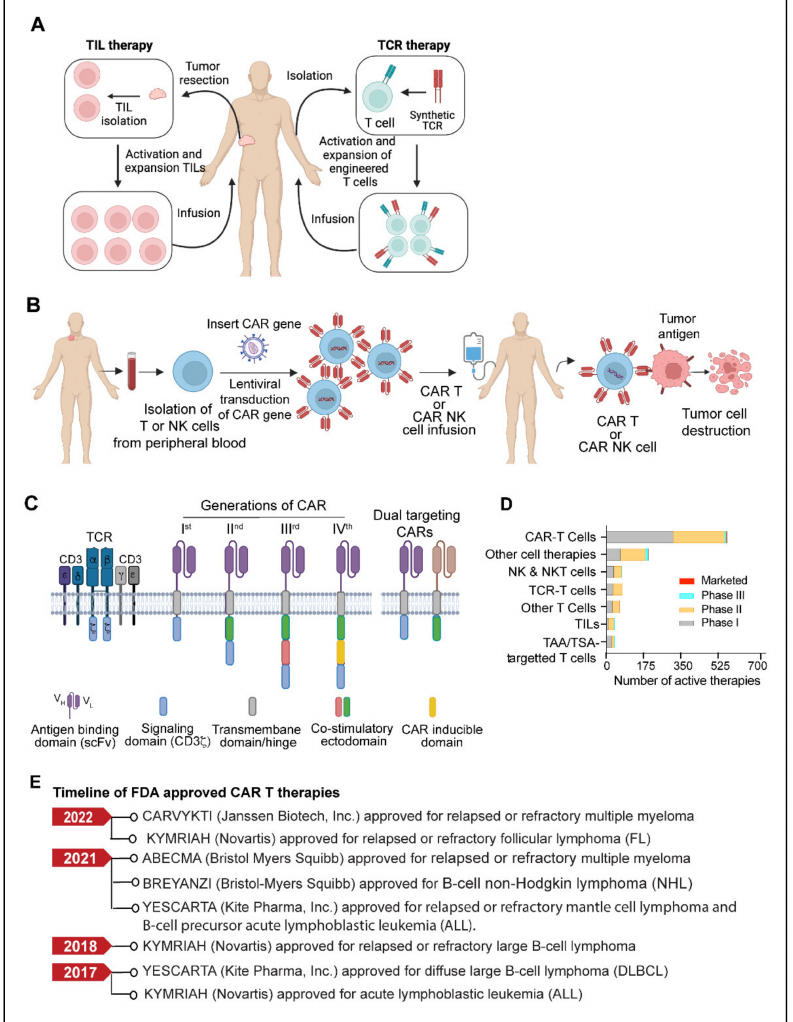
Figure 3. ( A ) Model showing TIL therapy and TCR therapy. ( B ) Schematic outline of CAR T or CAR NK therapy. Briefly, T cells or NK cells are isolated from the apheresis blood of a cancer patient, followed by the lentiviral mediated introduction of the CAR gene. The CAR-expressing cells are expanded ex vivo and infused back into the patient’s body. ( C ) Model depicting CAR structure and generations of different CARs. An antigen-binding domain typically consists of variable heavy (VH) and light (VL) chains from a monoclonal antibody assembled through a linker sequence to form a single chain variable fragment (scFv). In first-generation CAR, the scFv is linked via a hinge and transmembrane domain to the CD3 ζ , an intracellular T cell signaling domain of the T cell receptor. In the second and third-generation CARs, an additional one or two co-stimulatory domains are present. The fourth generation CARs are typically equipped with inducible domains A dual-targeting CAR contains two CARs, each targeting an independent antigen. (Created with BioRender.com) ( D ) Plots showing the preclinical and clinical trial status of different cell-based therapies for cancer treatment. ( E ) Timeline of U.S. FDA-approved CAR T therapies for various cancers. (Abbreviations: CAR, chimeric antigen receptor; NK, natural killer; TCR, T cell receptor; NKT, natural killer T cell; TAA, tumor-associated antigen; TSA, tumor-specific antigen; TIL, tumor-infiltrating lymphocytes; FDA, food and drug